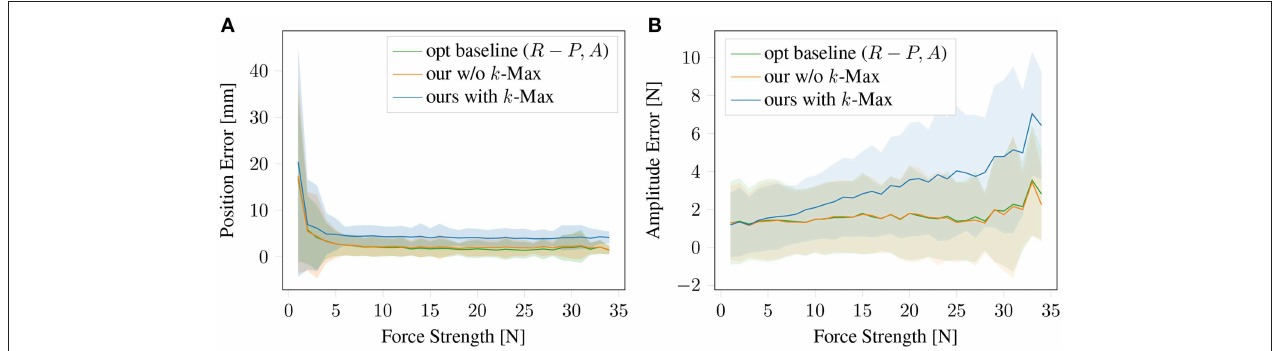
FIGURE 8 | Force position and magnitude prediction on single-contact data. Comparing our architecture with the method only usable in the single-contact case: the optimal baseline mapping directly from sensors to the target and our entire framework without k-Max but instead predicting P , A from D directly. (A) Contact position prediction error and (B) Force magnitude prediction error.